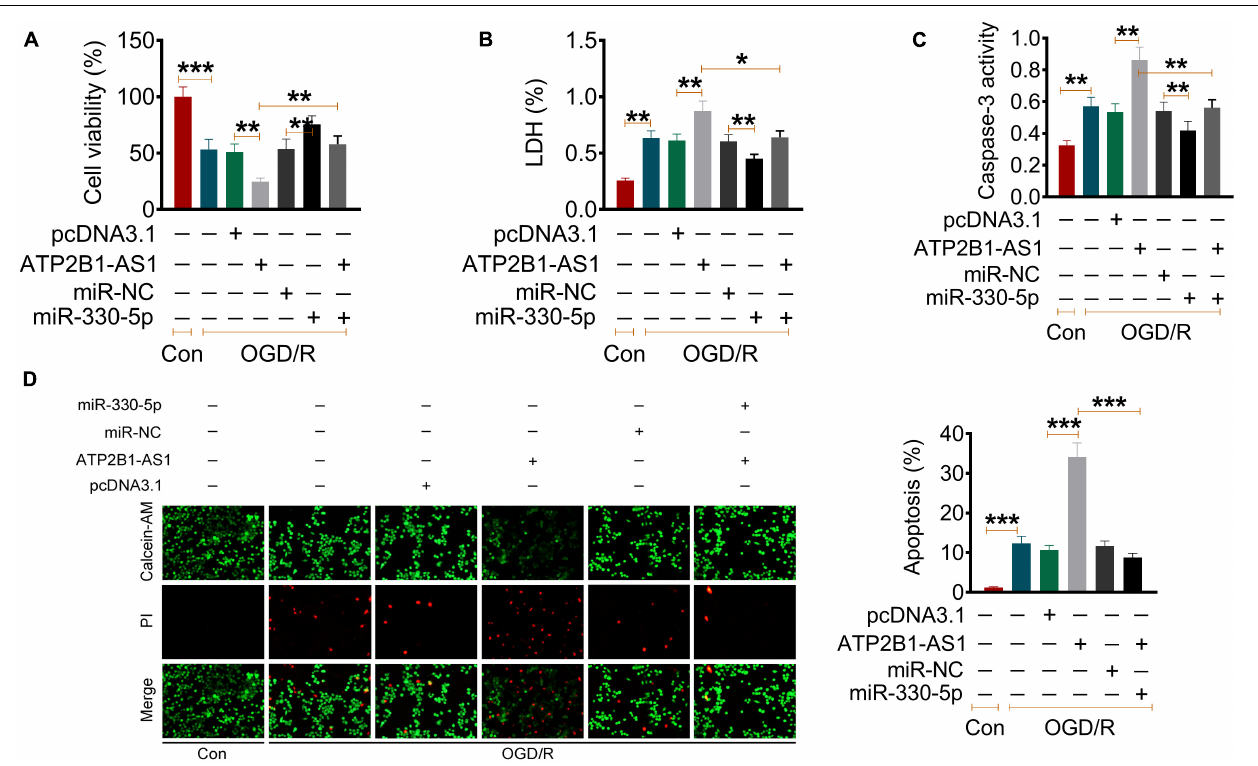
FIGURE 6 | Effect of ATP2B1-AS1 and miR-330-5p on the cell viability, apoptosis, cytokines, and TLR4-MyD88-NF- κ B signaling pathway in OGD/R PC12 cells. (A–D) The effect of pcDNA3.1-ATP2B1-AS1 and miR-330-5p mimics on the cell viability (A) , LDH level (B) , Caspase 3 activity (C) , and apoptosis rate (D) of OGD/R PC12 cells. PcDNA3.1-ATP2B1-AS1 reduced the cell viability, increased the LDH level, Caspase 3 activity, and apoptosis rate of OGD/R PC12 cells. These effects of ATP2B1-AS1 on OGD/R PC12 cells were abrogated by miR-330-5p mimics. * P < 0.05, ** P < 0.01, *** P <